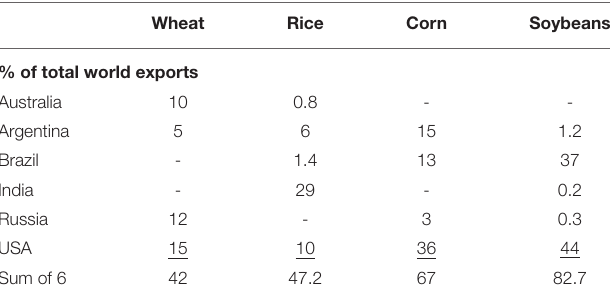
TABLE 1 | Exports of wheat, rice, corn and soybeans from six export origins, as a percentage of total world exports. Wheat Rice Corn Soybeans % of total world exports Australia